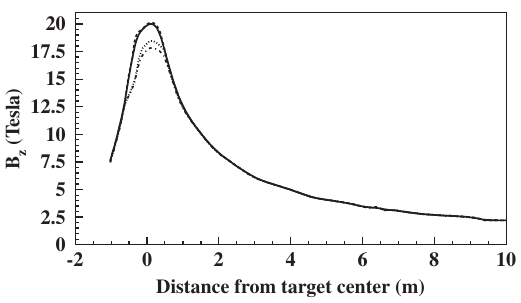
FIG. 2. Longitudinal magnetic field in the NF/MC front-end channel. The lines represent various radial positions r ð cm Þ ¼ 0 (solid), 15 (dashed), 21 (dotted), and 27